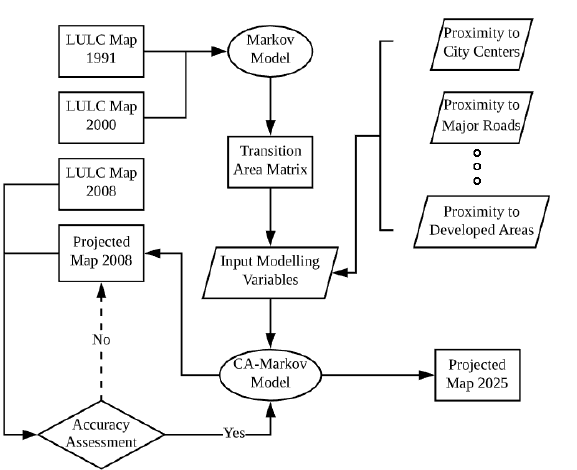
Figure 2. Land use land cover simulation process